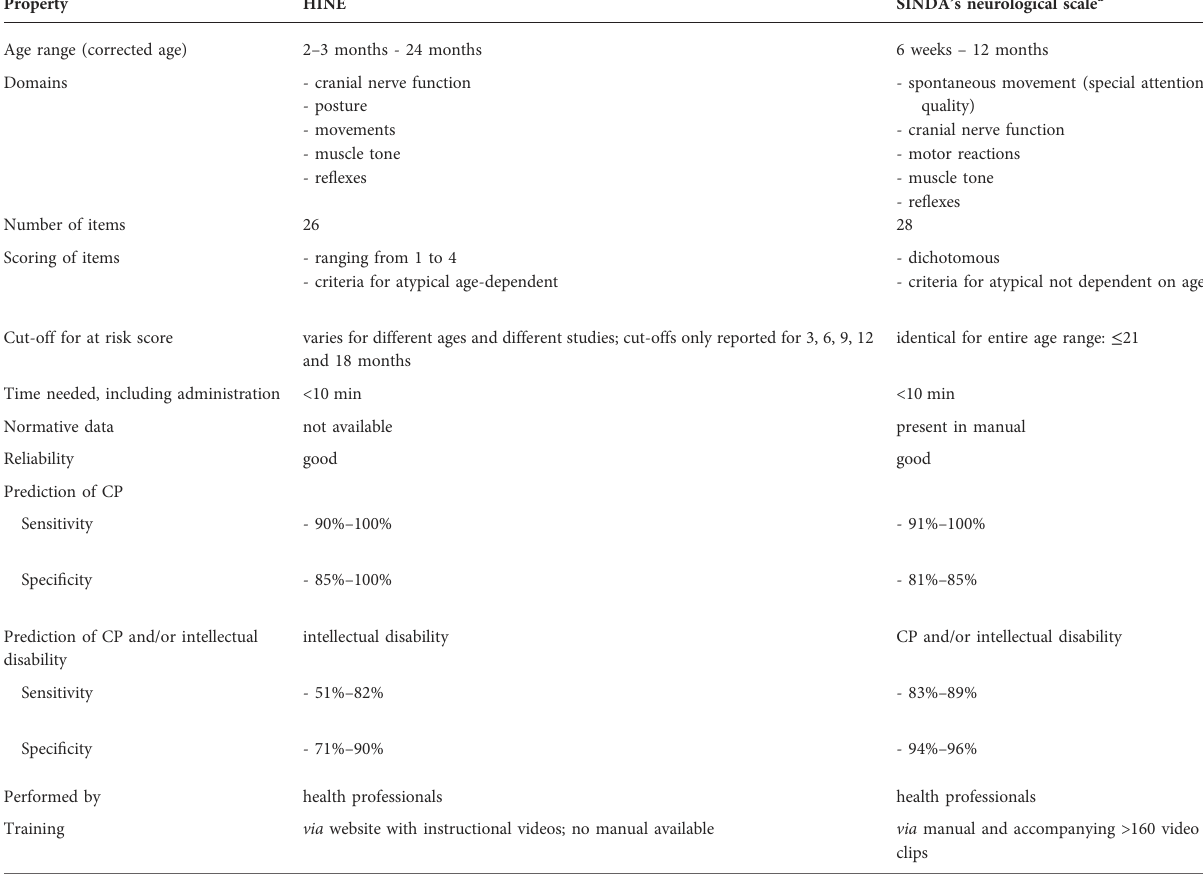
TABLE 2 Properties of HINE and SINDA ’ s neurological